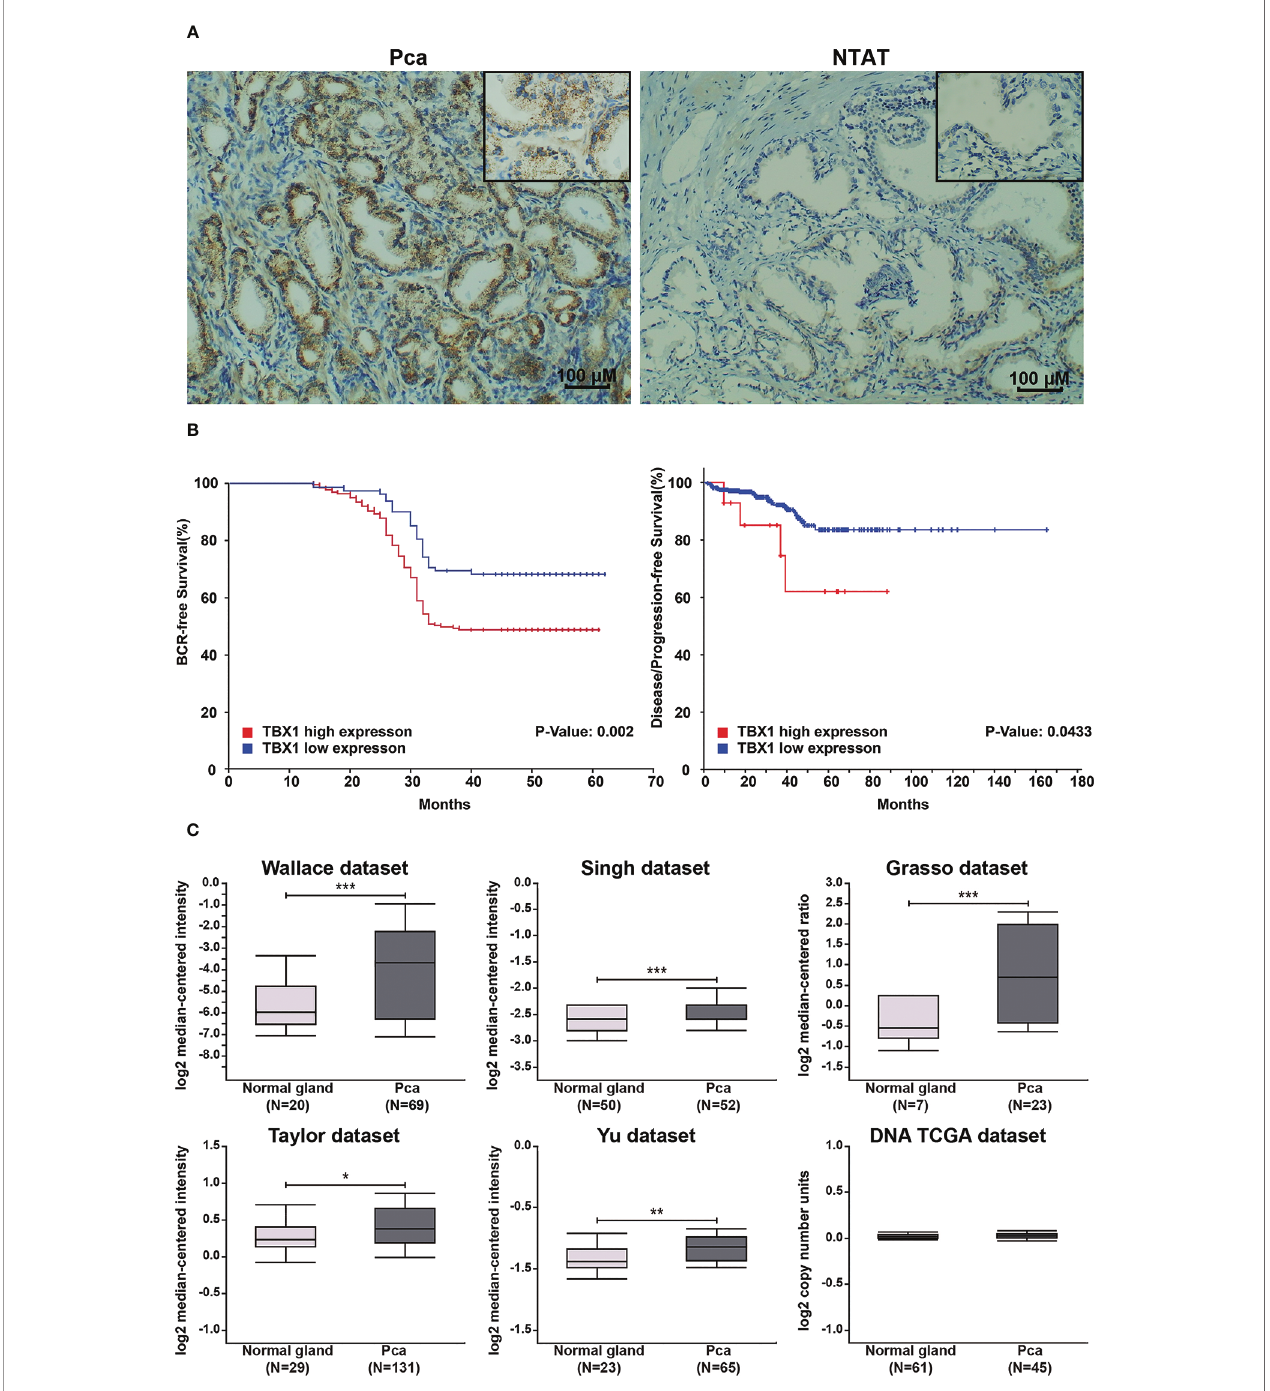
FIGURE 1 | High TBX1 expression is related to poor prognosis in PCa. (A) Left, TBX1 is expressed at high levels in PCa tissues, and TBX1-positive cells exhibit nuclear and cytoplasm staining. Right, TBX1 is absent in non-neoplastic tissues. (B) Kaplan – Meier curves demonstrating the survival distribution strati fi ed by TBX1 expression level. Left, biochemical recurrence-free survival determined from 280 PCa samples in the study. Right, disease/progression-free survival determined from 499 PCa samples in the TCGA database. (C) Analysis of microarray TBX1 expression data from the Oncomine database. Analysis of the log 2 median intensity values of TBX1 was conducted using six different datasets. TBX1 is commonly expressed at high levels in PCa tissues. * p < 0.05; ** p < 0.01; *** p < 0.001. Prostate cancer, PCa; Non-neoplastic tissue adjacent to the tumor, NTAT; Biochemical recurrence